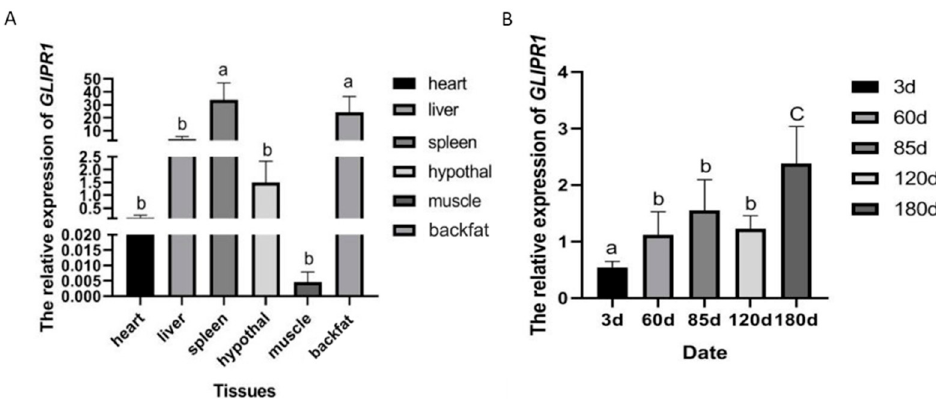
Figure 1. Comparison of relative expression of GLIPR1 gene in different tissues of 180 day old pigs ( A ) and in backfat tissues among different growth ages of Large White pigs ( B ). Different letters indicate significant differences among the expression levels of GLIPR1 gene at p < 0.05. Three biological replicates of each set were performed for qPCR.